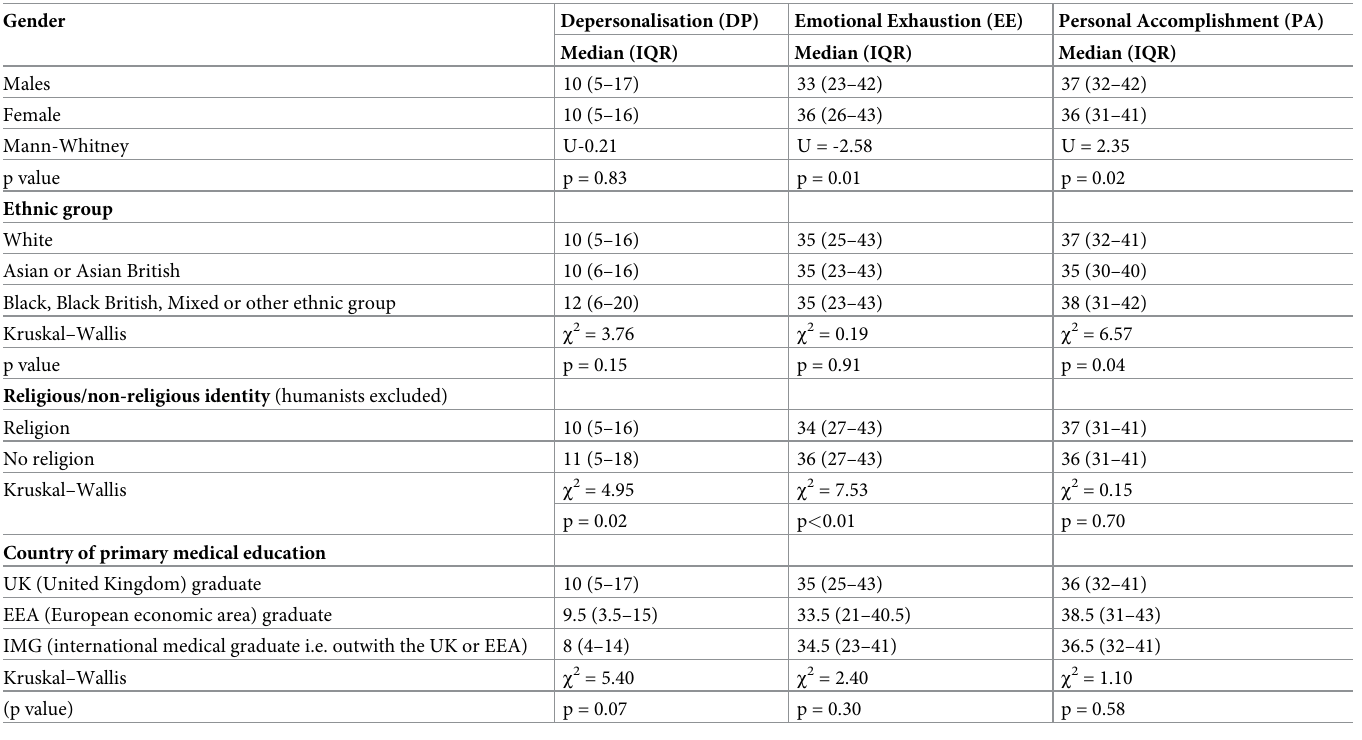
Table 2. Median burnout domain scores compared by gender, ethnicity, and country of primary medical education.